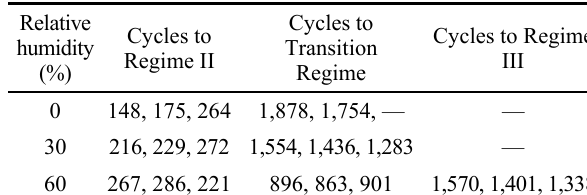
Table 1 No. of cycles required for onset of different regimes at varying relative humidity. Values are given for each individual test because the progression to the different regimes is not highly repeatable.